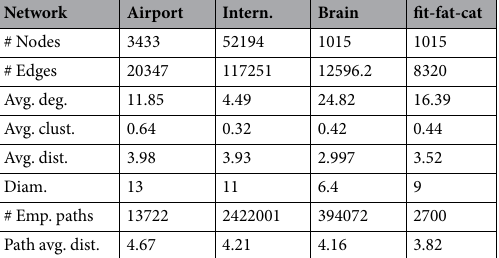
Table 1. Basic structural properties of our networks and paths we have analyzed.